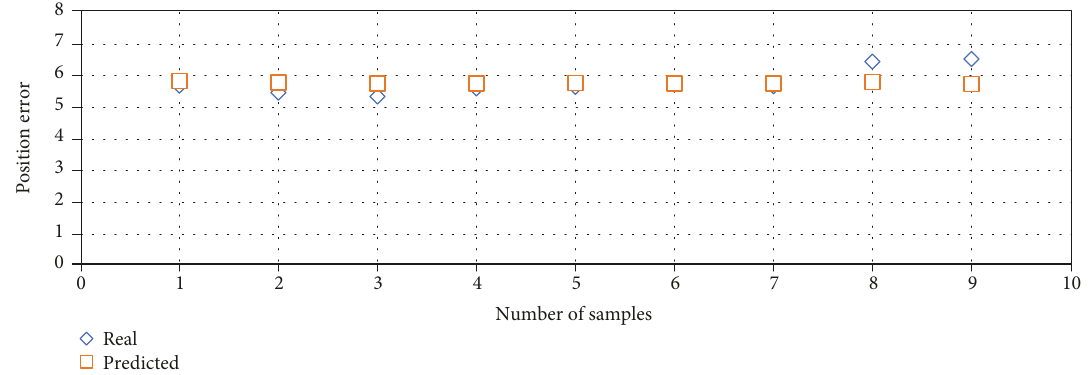
Figure 1: Comparison of the forecast and actual position error of the